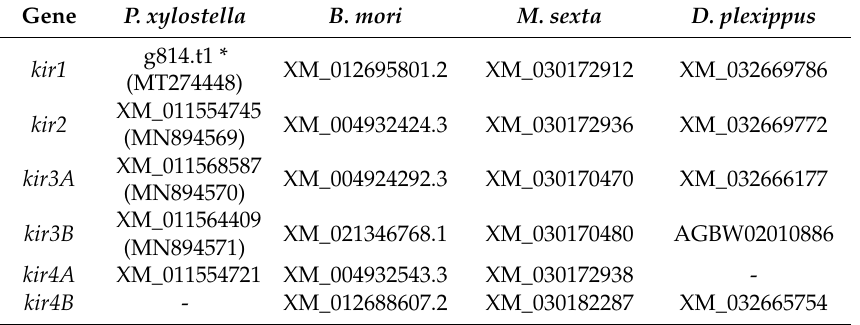
Table 2. The kir genes of P. xylostella , B. mori , M. sexta , and D. plexippus in